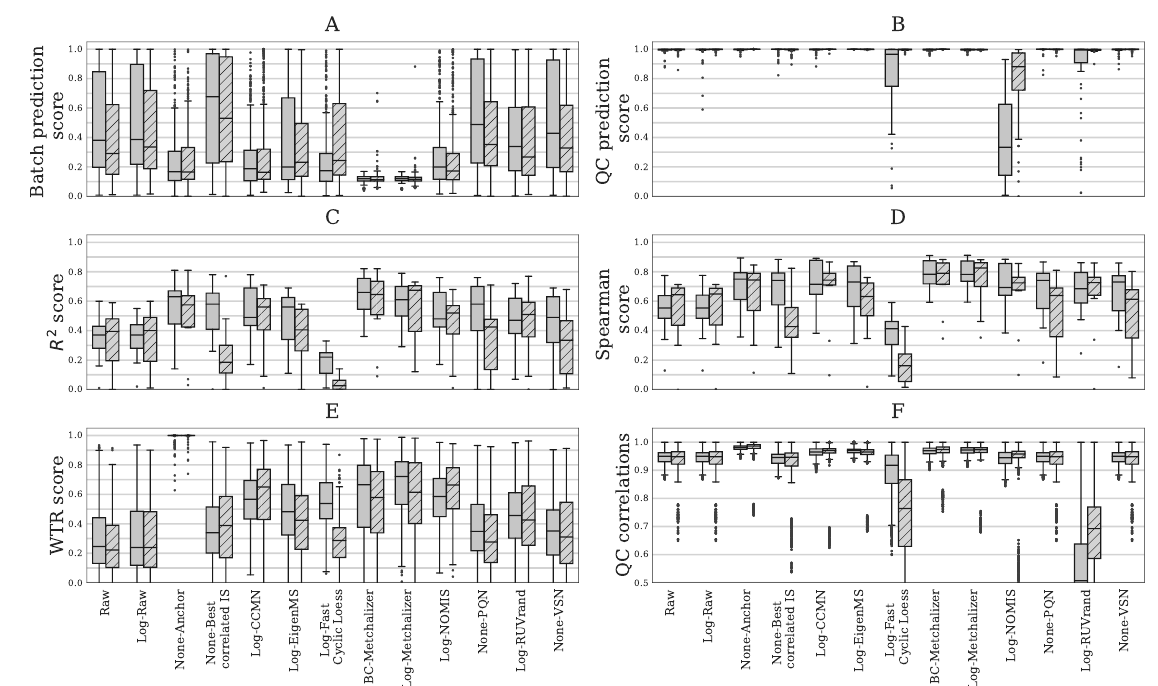
Figure 2. Six different performance metrics for batch effect removal (Section 4.4.5). Data from positive – or negative ion mode is indicated by plain and striped boxplots, respectively. ( A ) Batch prediction score measures the presence of batch effects in the first four principal components (PCs) from PCA analysis. ( B ) Quality Control (QC) prediction score measures how well QC samples are separated from human plasma sample in the first four PCs. ( C ) R 2 score between (normalized) abundancies and quantitative measurements. ( D ) Spearman score of (normalized) abundancies with quantitative measurements. ( E ) The WTR score measuring the overall within batch variation with respect to the total variance using the QC samples. ( F ) QC correlations measuring the resemblance of all QC samples among each other. Each data point represents a pair-wise Spearman correlation between two QC